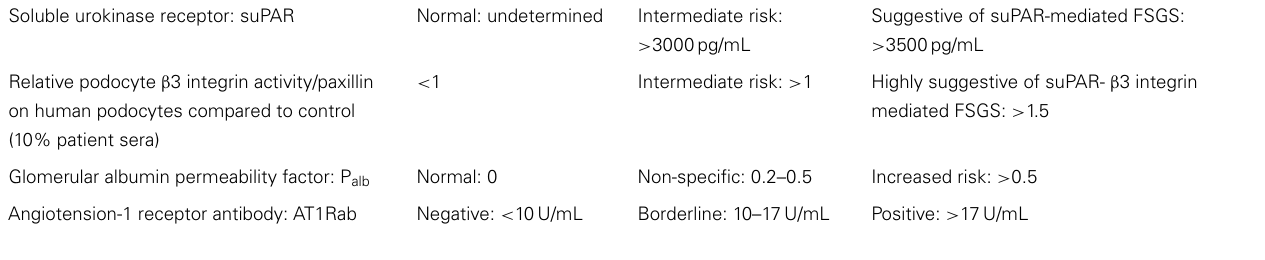
Table 2 | Interpretation of putative markers in FSGS.